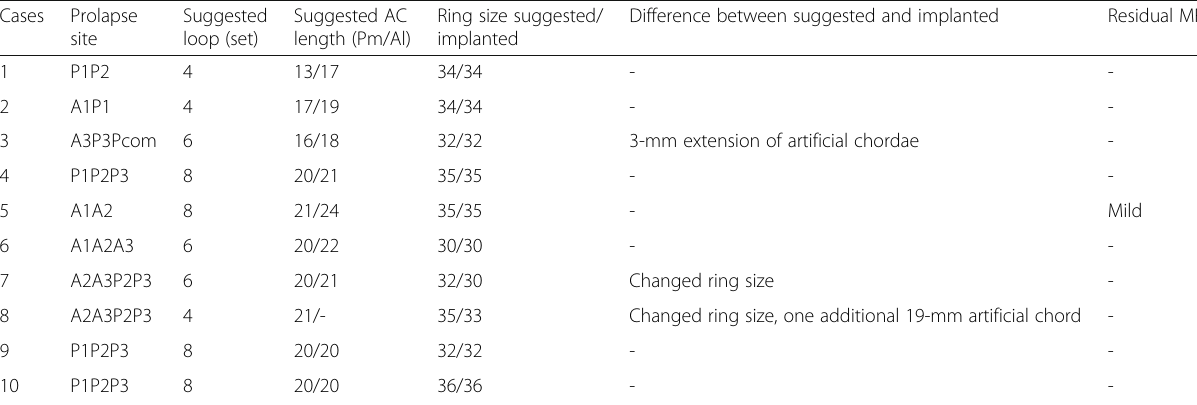
Table 2 Departure site of the mitral valve, loop set count, planned and actually used ring sizes, changes in surgical plan, and residual postoperative